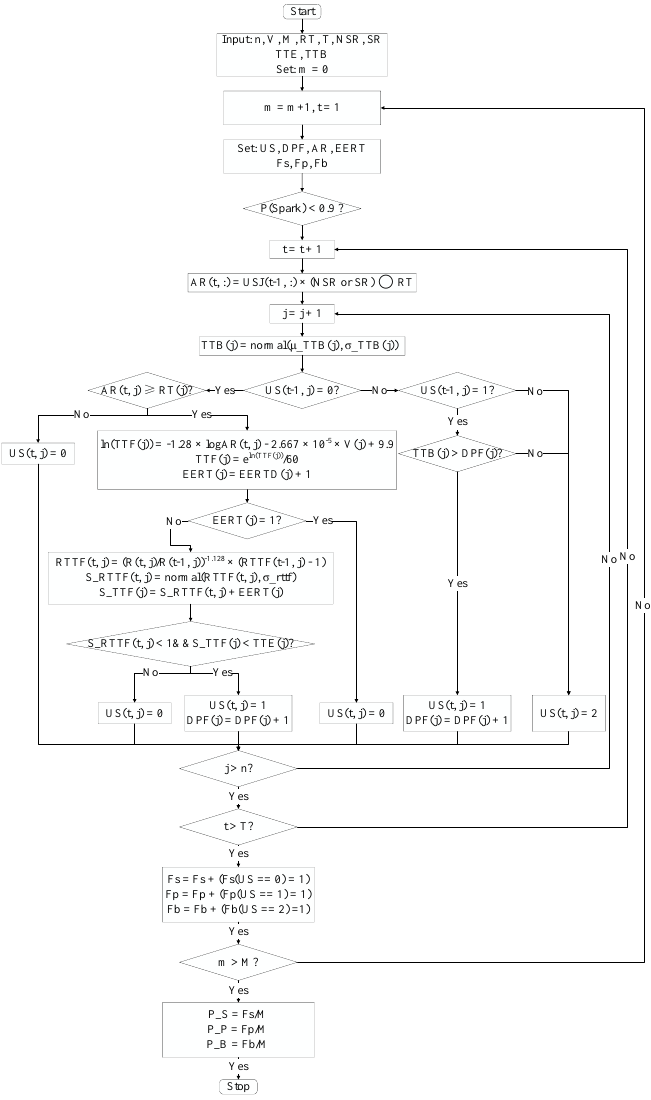
Figure 5. Flowchart of dynamic domino effect probability calculation.